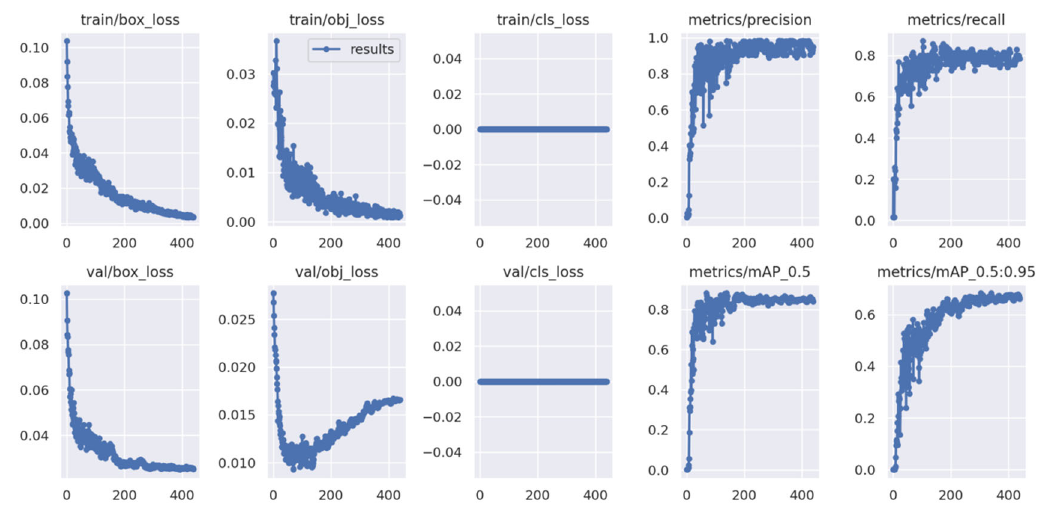
Figure 3. The results of AC ‐ YOLOv5 model training.